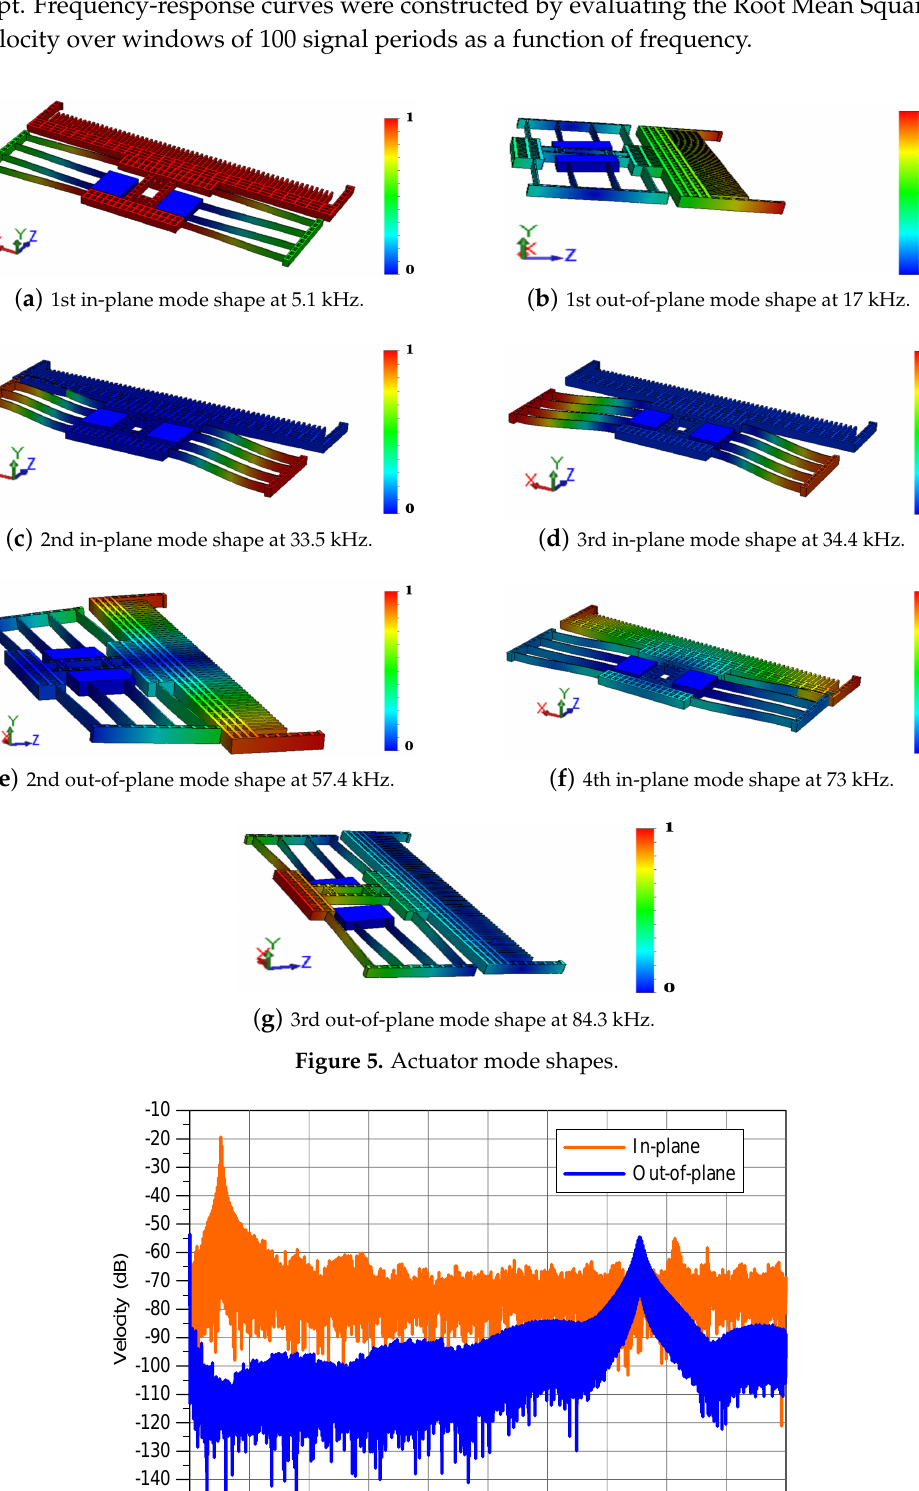
Figure 6. FFT of the measured out-of-plane and in-plane velocities of the back edge under a pulse train of a 75V amplitude, 200Hz frequency, and 1% duty